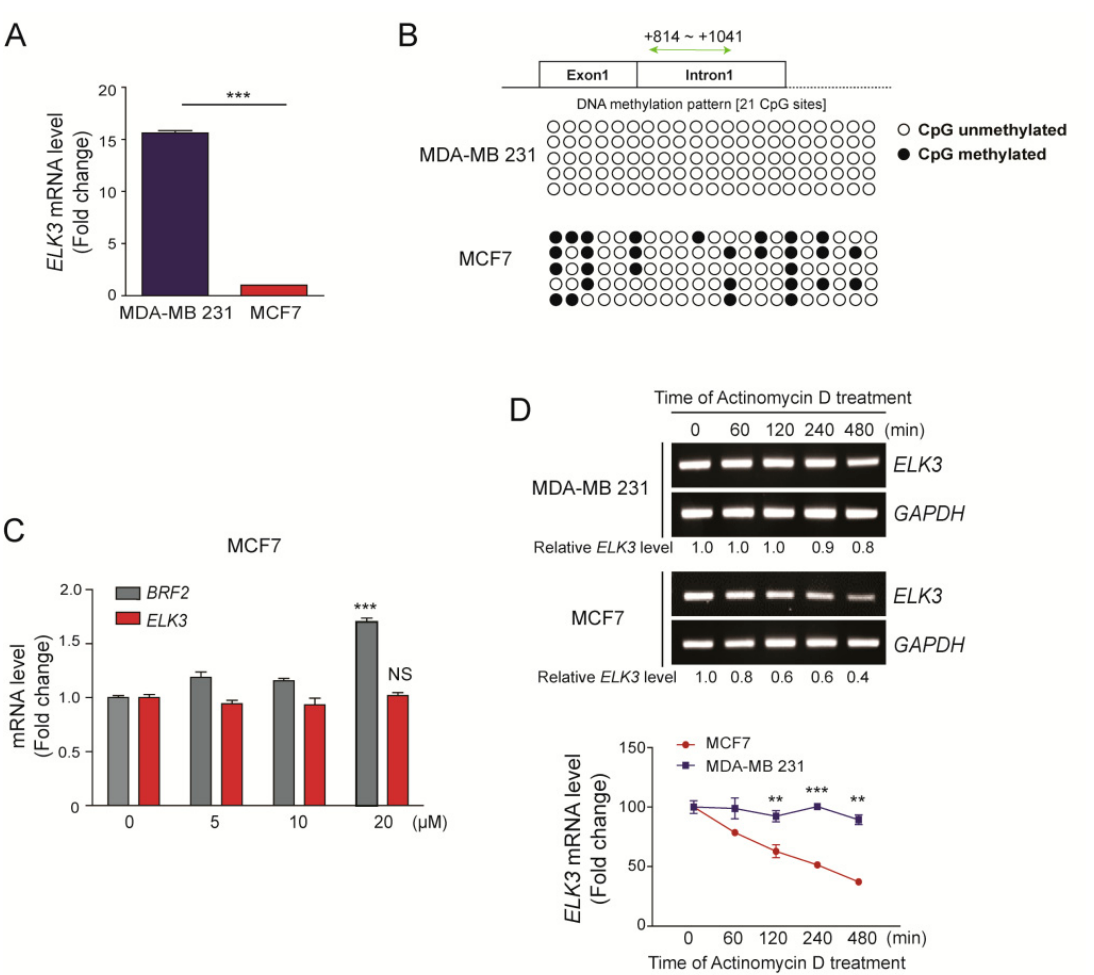
Figure 1. Differences between the expression levels of the ELK3 mRNA in MDA-MB 231 and MCF7 cells are independent of genomic DNA methylation. ( A ) A quantitative analysis of the ELK3 mRNA level in MDA-MB 231 and MCF7 cells. Error bars represent the S.E.M.; *** p < 0.001 (Student’s t -test). ( B ) Methylation pattern of the first intron region of the ELK3 gene in MDA-MB 231 and MCF7 cells. Methylation of 21 CpG islands in the first intron of ELK3 (+814 ~ +1041) was analyzed by bisulfite sequencing. White circles indicate unmethylated CpG sites, and black circles indicate methylated CpG sites. ( C ) Effect of 5’-azacytidine treatment of MCF7 cells on expression of the ELK3 mRNA. MCF7